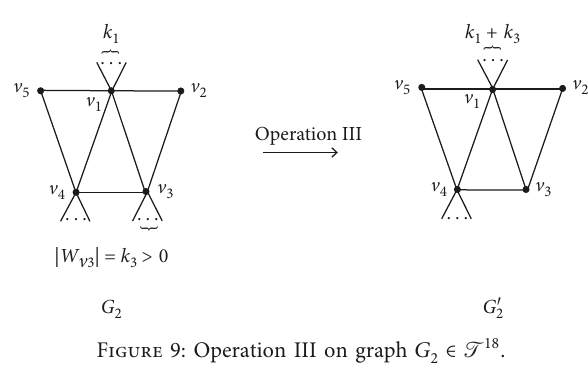
Figure 9: Operation III on graph G